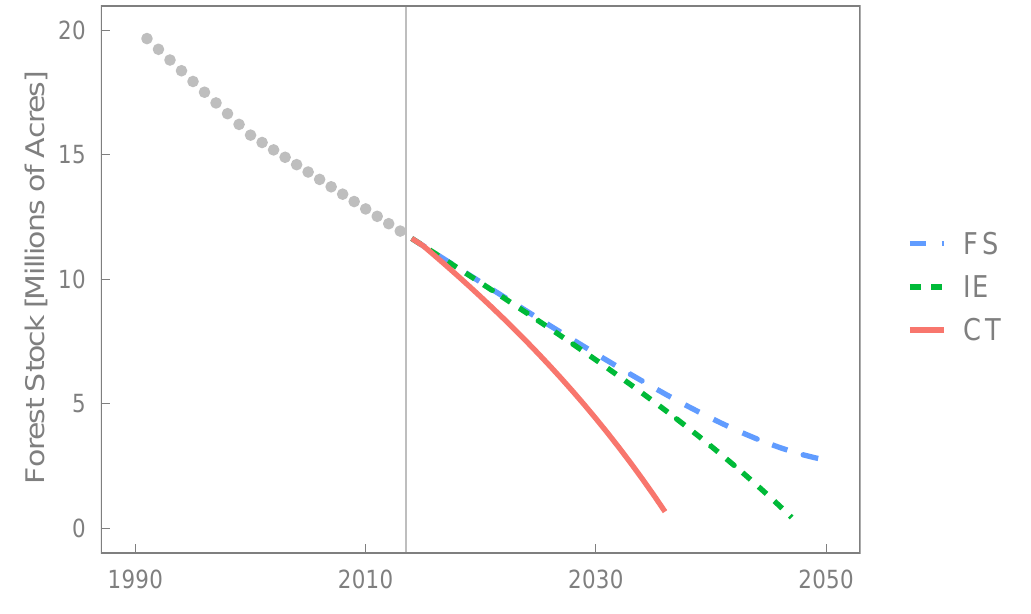
Figure 10. Forest stocks from 1990 to 2050 under the CT, IE, and FS